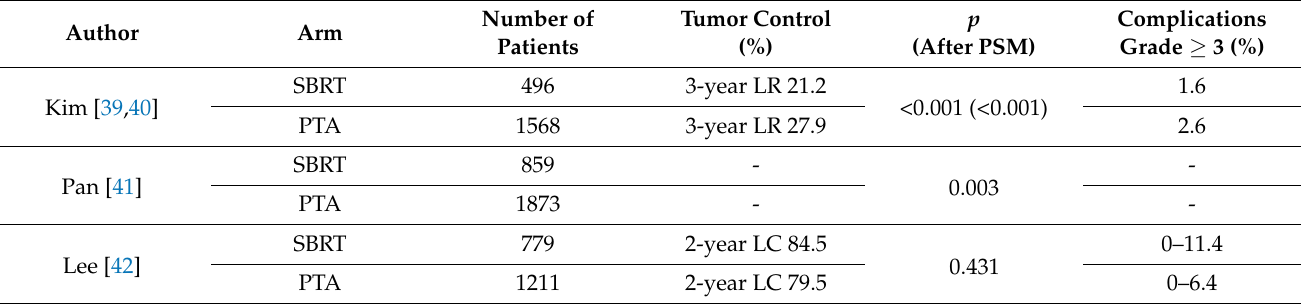
Table 5. SBRT versus Percutaneous Tumor Ablation (PTA): Multicentric retrospective studies and metanalysis.